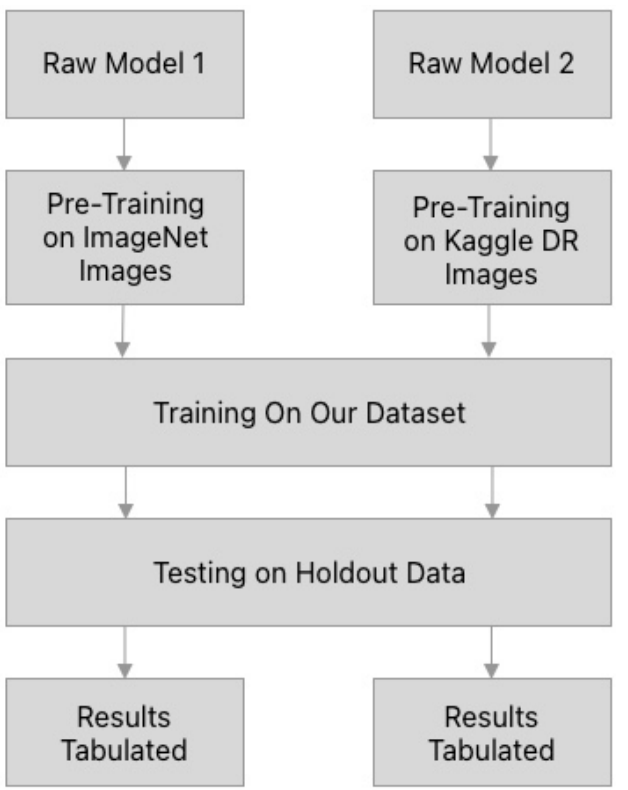
Figure 2. Visual representation of the methodology used to construct both the ImageNet and retinal image pretrained DL image pretrained DL models.